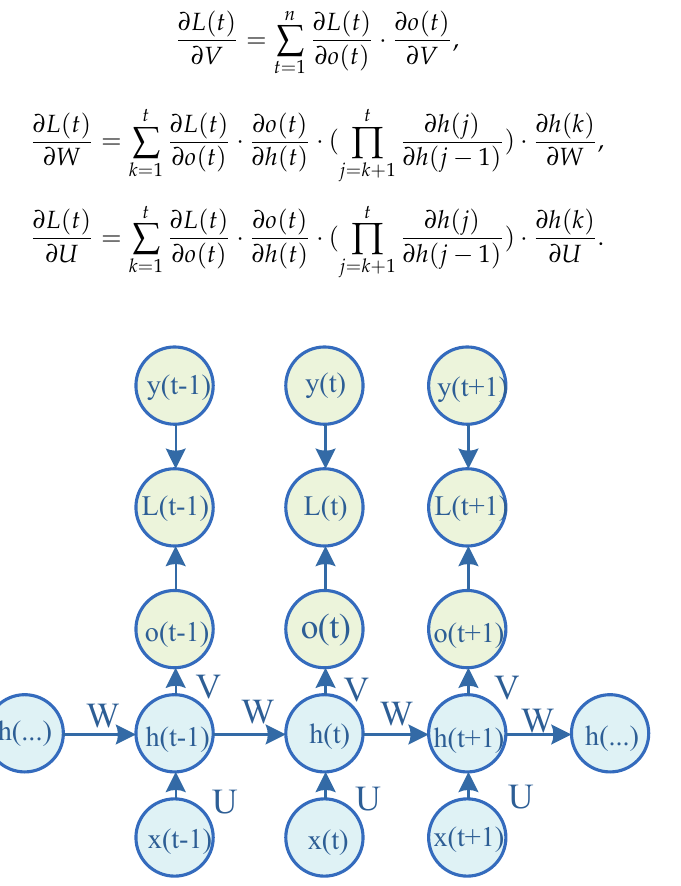
Figure 4. Recurrent neural network (RNN) cell unfold